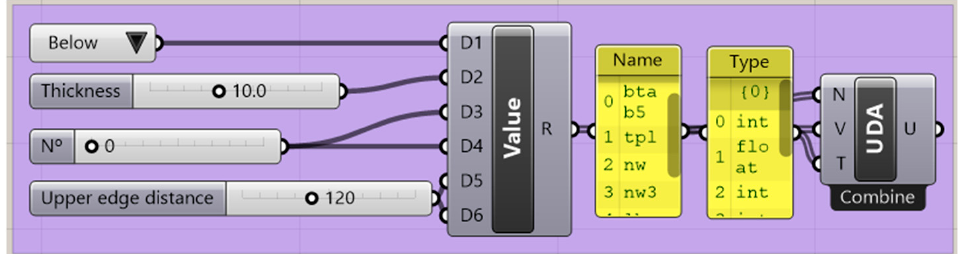
Figure 7. Attributes organization with user-defined attributes